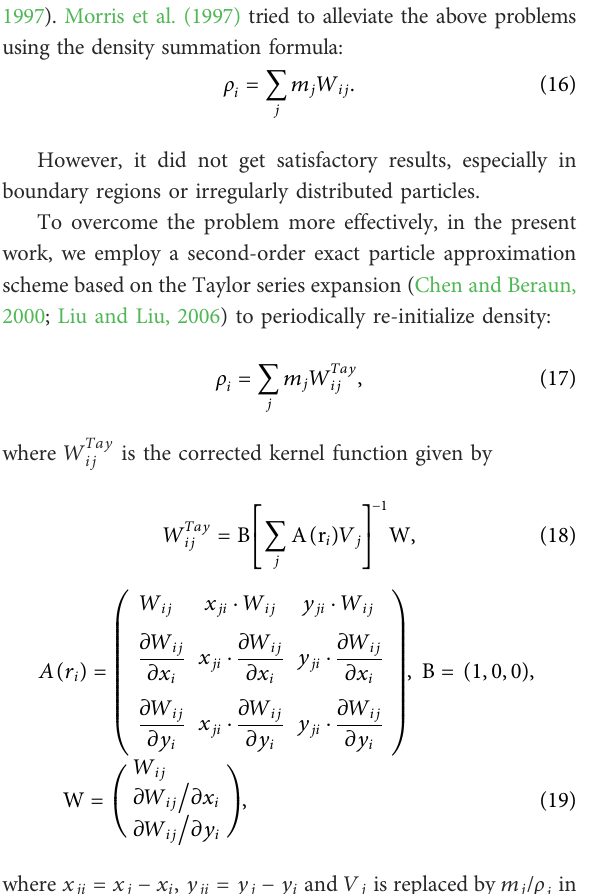
FIGURE 3 Comparison of droplet widths calculated using SPH and CSPH (the FDM result is obtained by Tome et